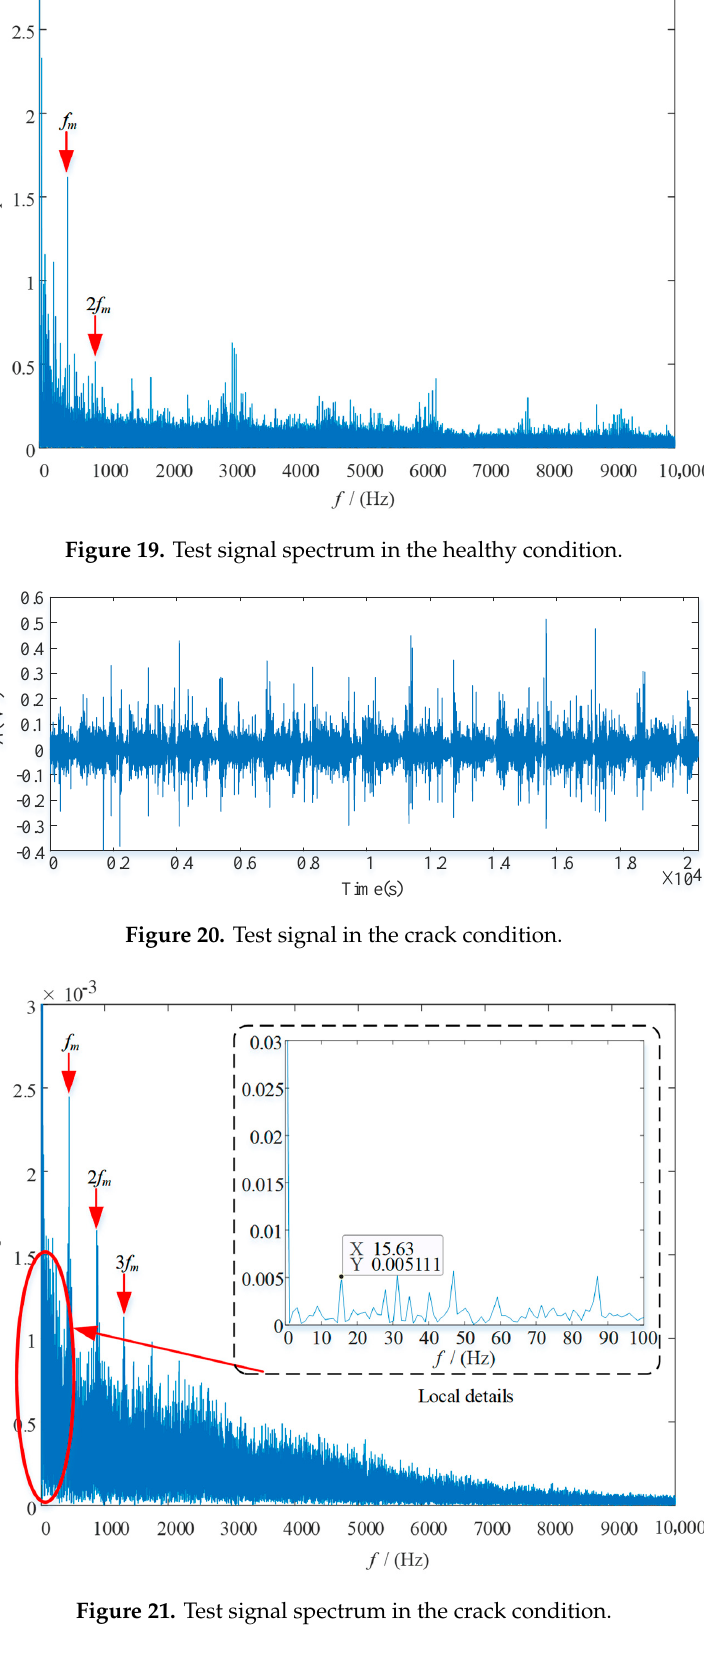
Figure 21. Test signal spectrum in the crack condition.